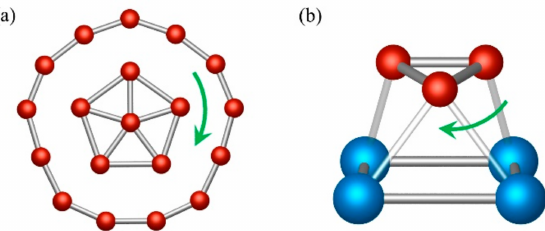
Figure 1. ( a ) The Wankel rotor B 19 − and ( b ) Three-dimensional molecular Reuleaux triangle B 3 Al 4+ .